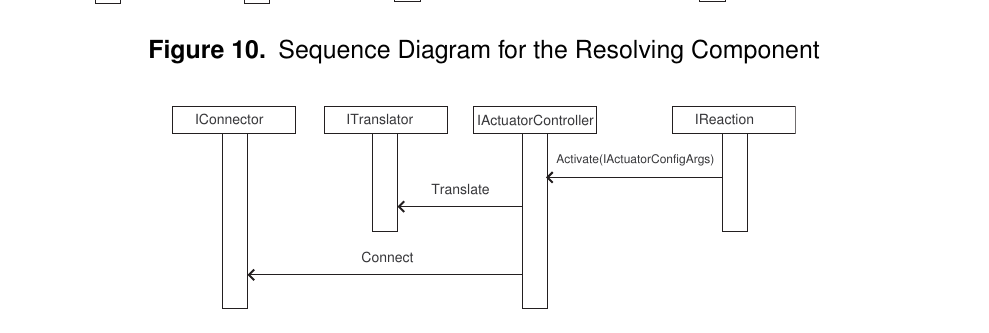
Figure 11. Sequence Diagram for the